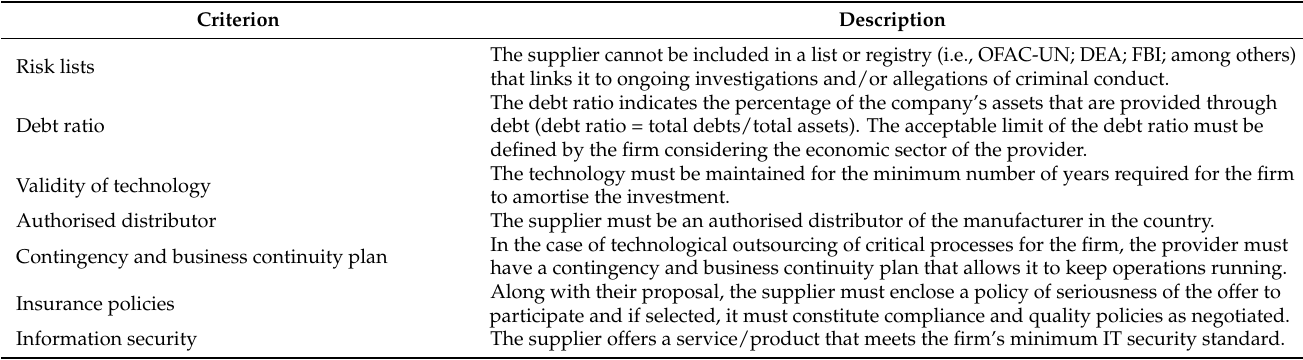
Table A1. Definition of criteria for supplier qualification of